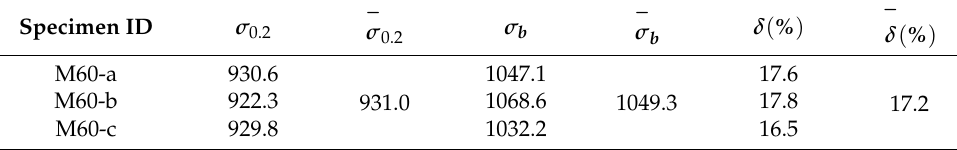
Figure 4. The tensile test on the standard specimens of M60 high-strength bolts. Table 1. The mechanical properties of the M60 high-strength bolt material.